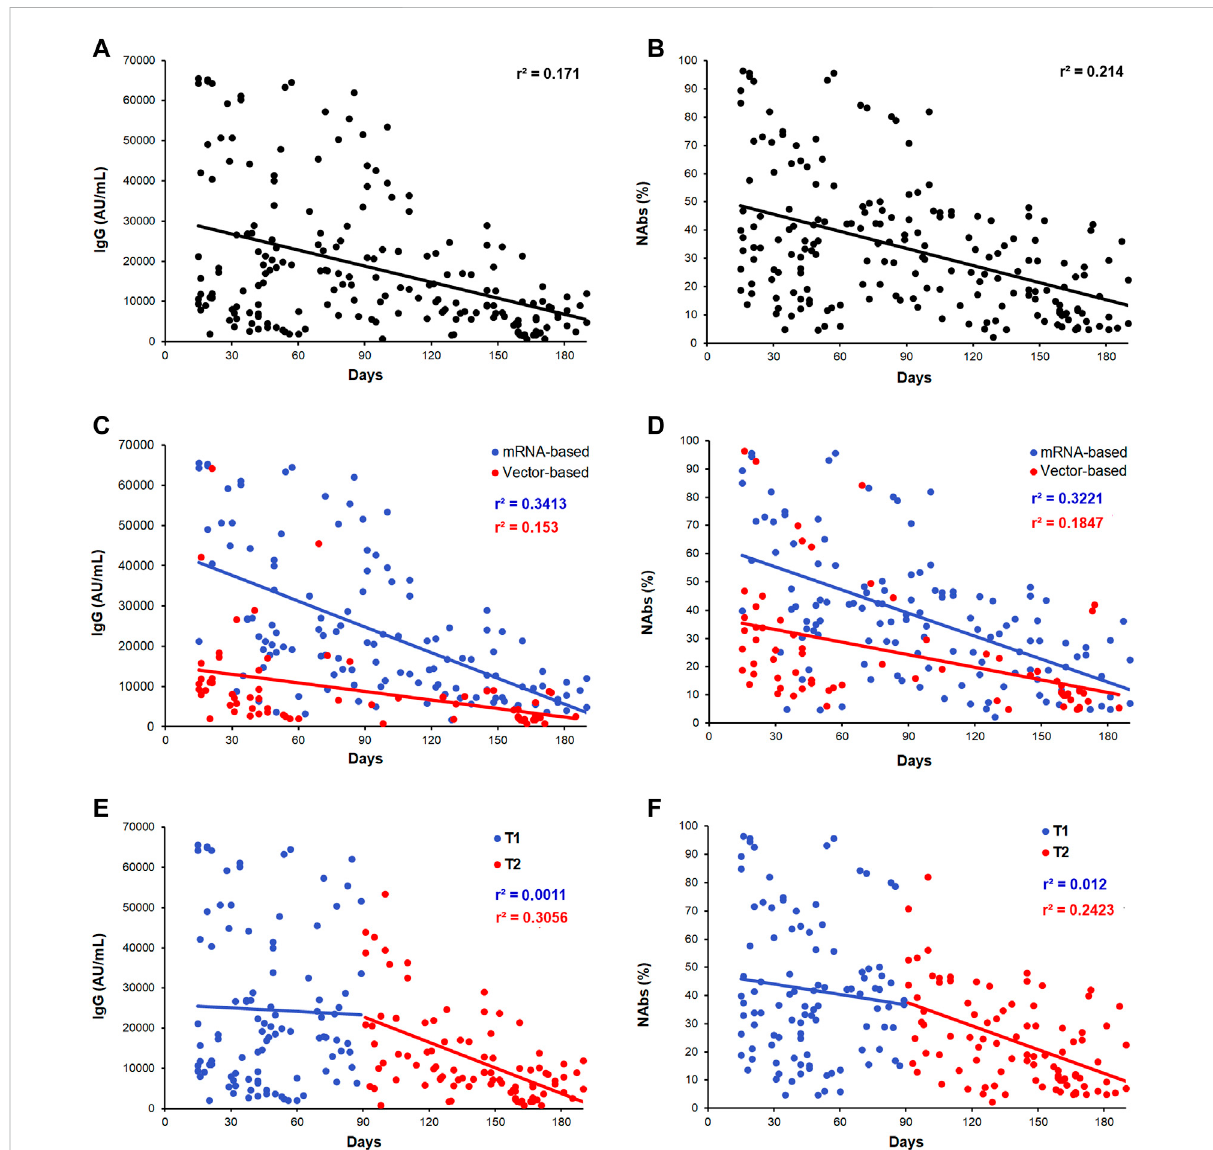
FIGURE 1 Scatter plots of the distribution of antibody levels after second dose of vaccine. (A,B) IgG and NAbs kinetic distributions in the whole cohort of subjects. (C,D) IgG and NAbs distribution strati fi ed by the vaccine type (mRNA-based vaccine: blue dots/line and vector-based vaccine: red dots/ line). (E,F) IgGandNAbsdistribution,respectively,strati fi edbyT1andT2recruitmenttime(T1:bluedots/lineandT2:reddots/line).Eachpanelshows the speci fi c regression line and the r -coef fi